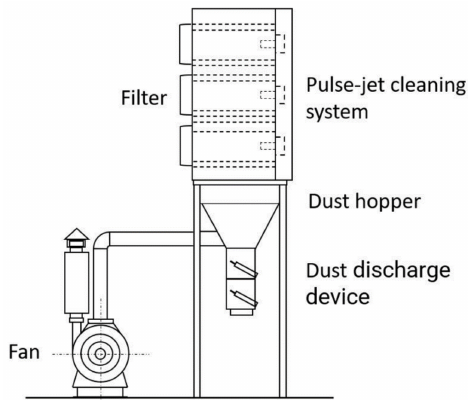
Figure 1. The pulse dust collection system.